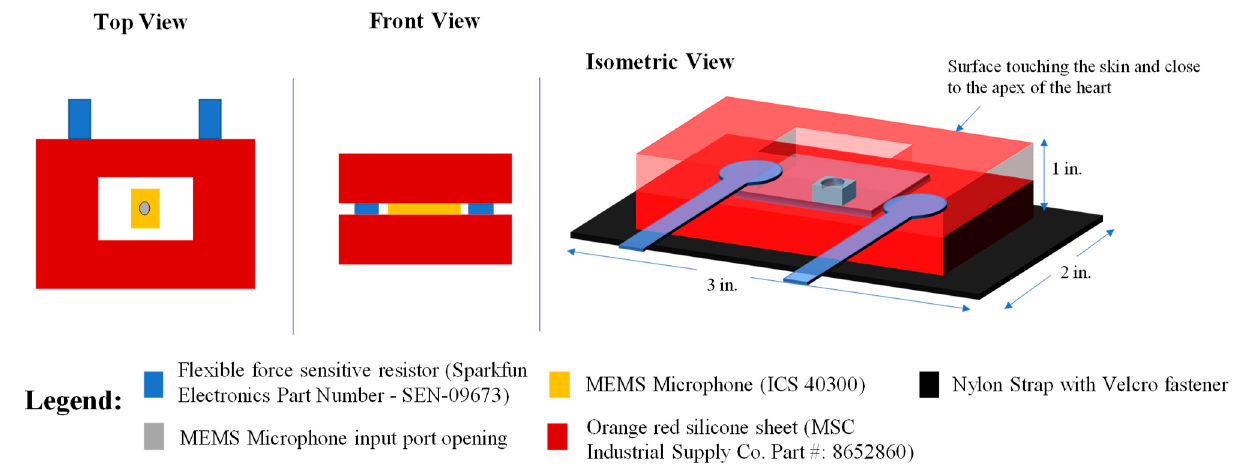
Figure 1. Illustration of the WPAS sensing component mounted on a belt.